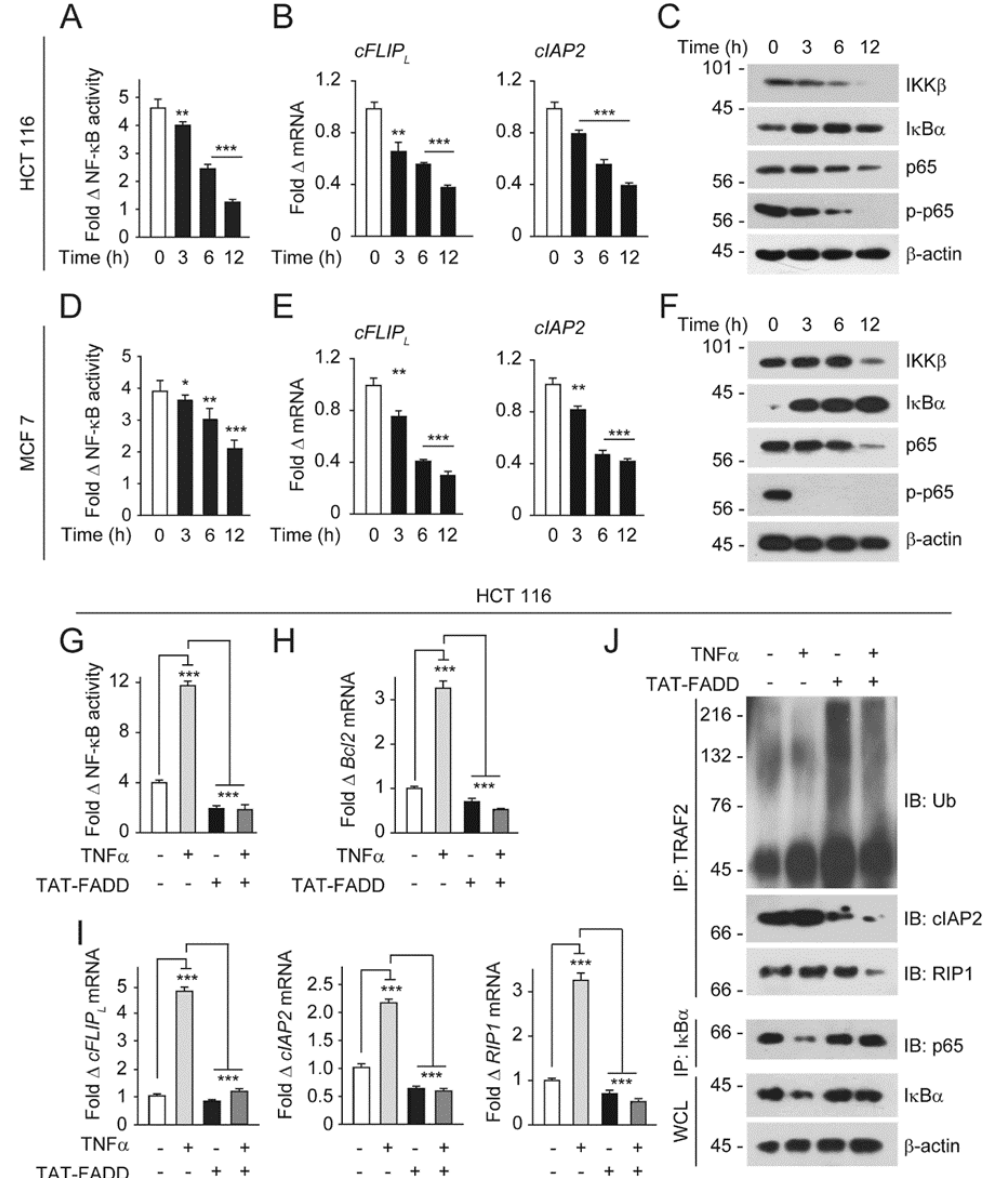
Figure 5. TAT-FADD suppresses constitutive and TNF- α -primed NF- κ B activation in cancer cells. ( A – C ) HCT 116 cells were treated with 5 µ M of TAT-FADD for 3–12 h and ( A ) NF- κ B luciferase activity, ( B ) mRNA expression of cFLIP L and cIAP2 , and ( C ) expression of NF- κ B signaling protein, molecular weight marker left to each blot. ( D – F ) MCF-7 cells were treated with 5 µ M of TAT-FADD for 3–12 h and ( D ) NF- κ B luciferase activity, ( E ) mRNA expression of cFLIP L and cIAP2 , and ( F ) expression of NF- κ B signaling protein, molecular weight marker left to each blot. Control represents untreated cells. ( G – J ) HCT 116 cells were primed with TNF- α (10 ng / mL) for 12 h followed by treatment of 5 µ M TAT-FADD for 6 h and ( G ) NF- κ B luciferase activity, ( H , I ) mRNA expression of ( H ) Bcl2 and ( I ) cFLIP L , cIAP2 and RIP1 , ( J ) TRAF2 was immunoprecipitated (IP) followed by binding analysis of ubiquitin, cIAP2, and RIP1 protein by Western blot, molecular weight marker left to each blot. Control represents untreated cells. In ( A , B , D , E ), significance compared between non-treated (represents as 0 h) and TAT-FADD-treated cells; in ( G – I ), significance is compared between non-treated (white bars) and TNF- α -primed cells (gray bars); and between TNF- α -primed cells and TAT-FADD-treated cells (black and dark gray bars respectively). h, hours; WCL, whole cell lysate. Mean ± SD; * p ≤ 0.05, ** p ≤ 0.01, and *** p ≤